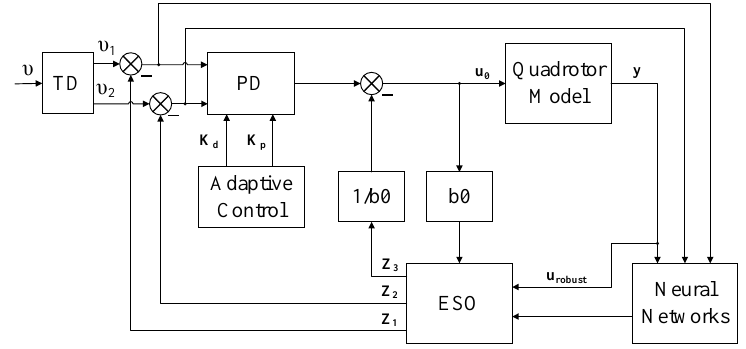
Figure 3. RBF − ADRC control system for quadrotor UAV.